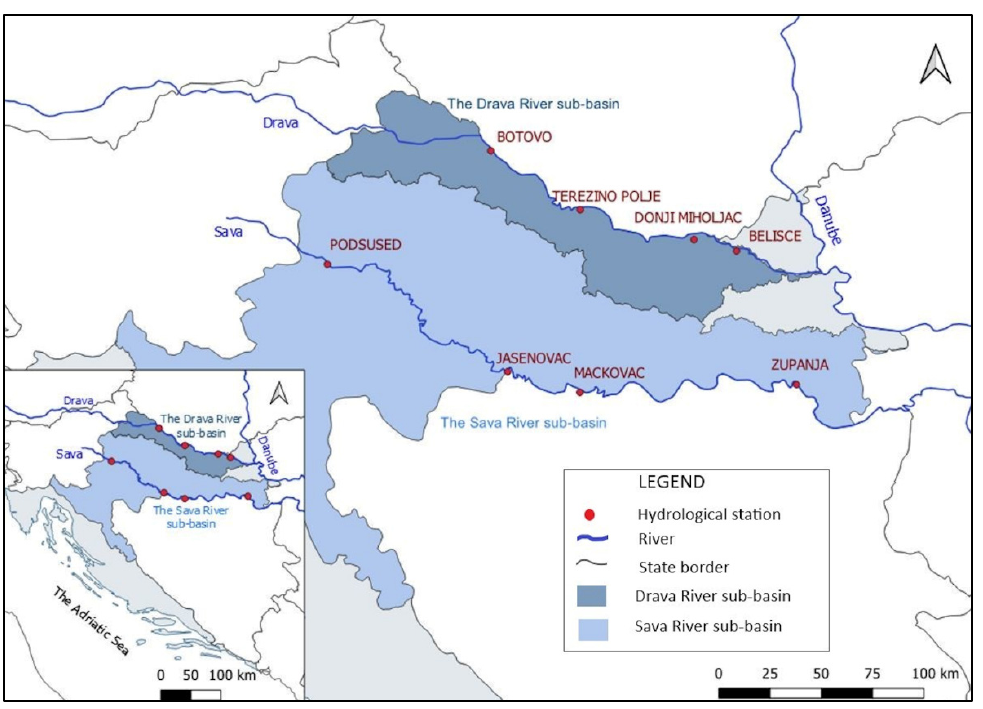
Figure 1. Location of the observed gauging stations on the Drava River and the Sava River in Croa-